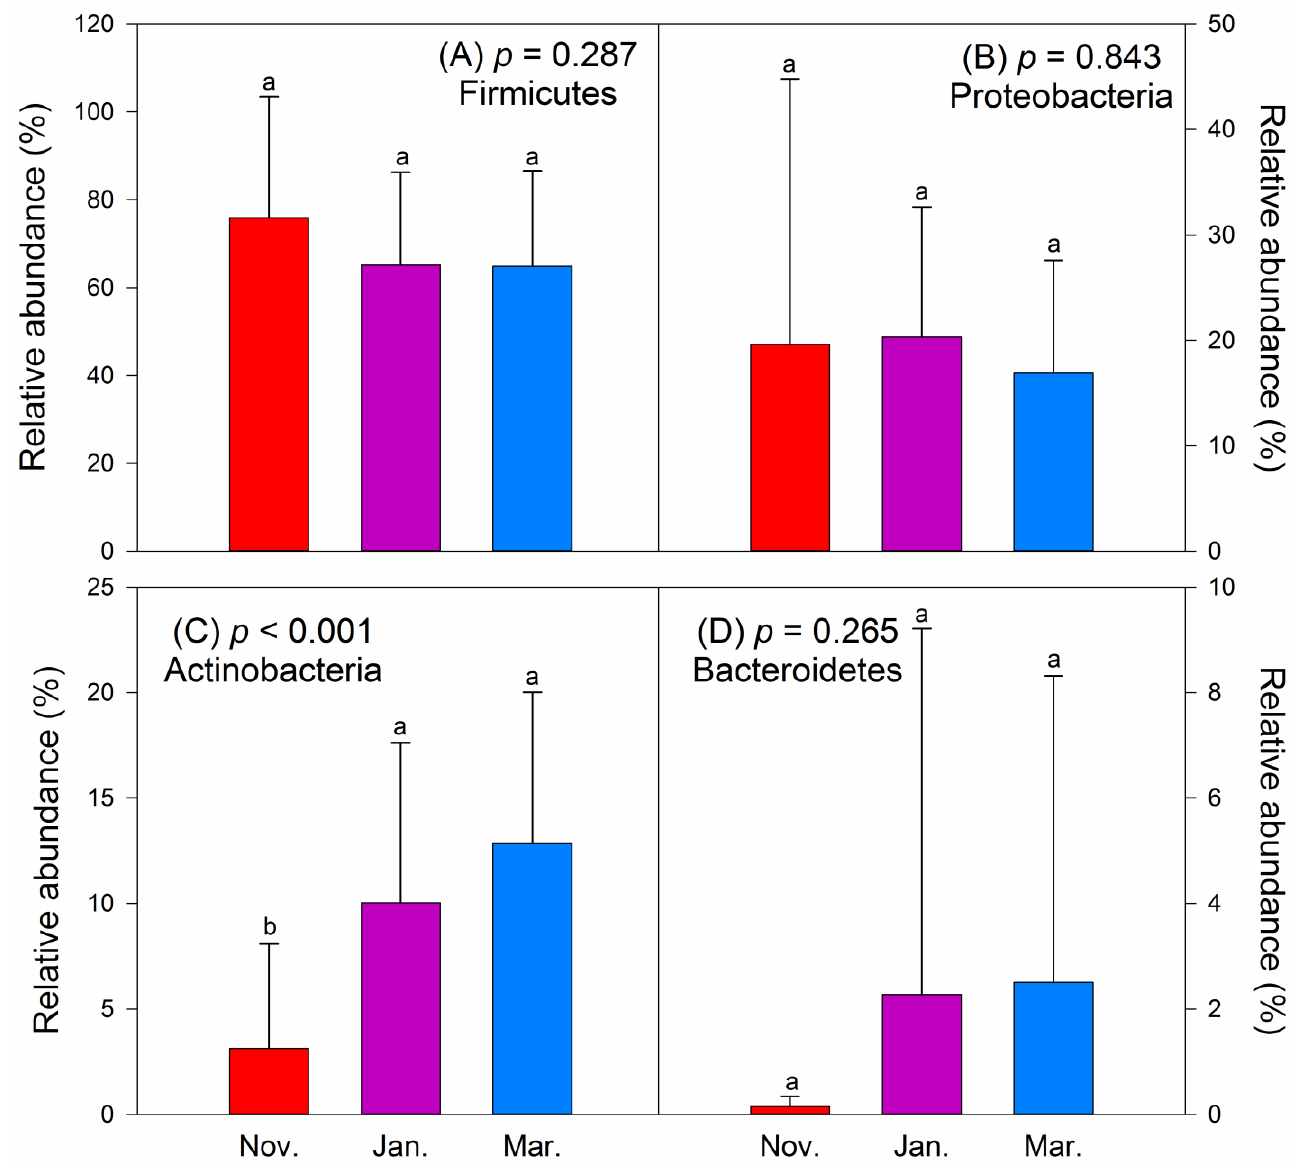
Figure 2. Relative abundance (%) of the dominant intestinal bacterial phyla of hooded cranes in the 3 months. ( A ) Firmicutes; ( B ) Proteobacteria; ( C ) Actinobacteria; ( D ) Bacteroidetes. Letters over the bars indicate pairwise differences according to Tukey honestly significant difference (HSD) test in ( A – C ) and Dunn–Bonferroni test in ( D ) at the p < 0.05 level. Coloured bars indicate the mean value, and error bars represent the standard